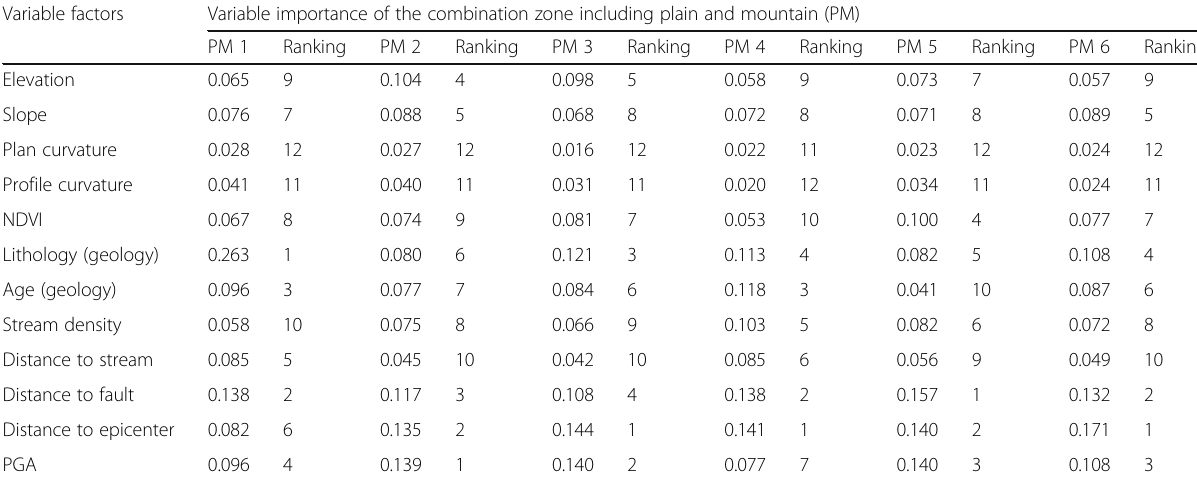
Table 2 Variable importance and ranking for the combination zone including plain and mountain (PM) Variable factors Variable importance of the combination zone including plain and mountain (PM)